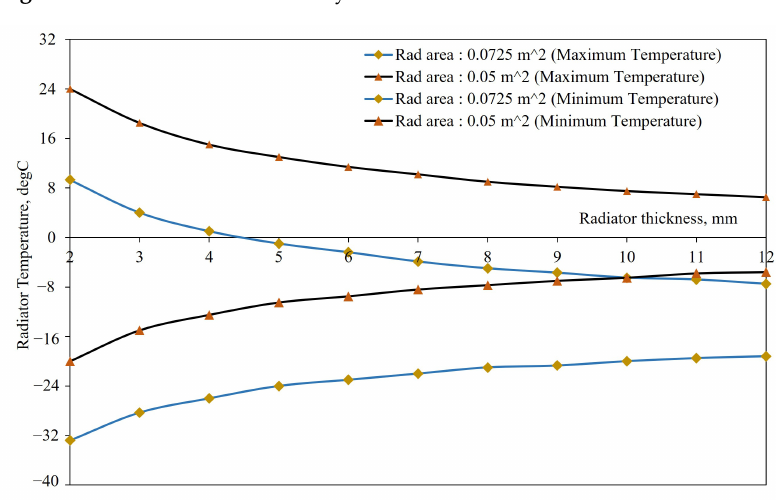
Figure 26. BMR —Thickness Study.